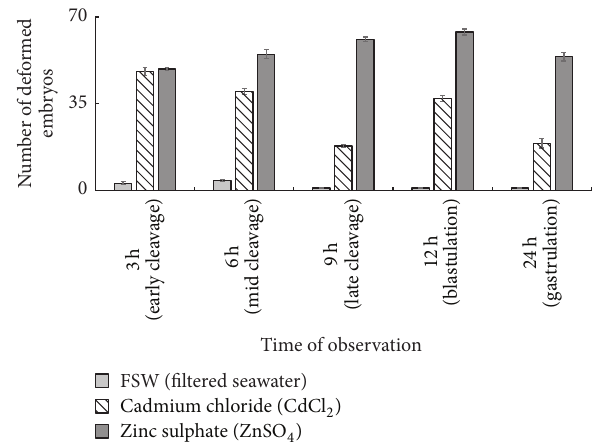
Figure 4: Number of deformed embryos observed under the three treatments considered starting from early cleavage up to 2-arm